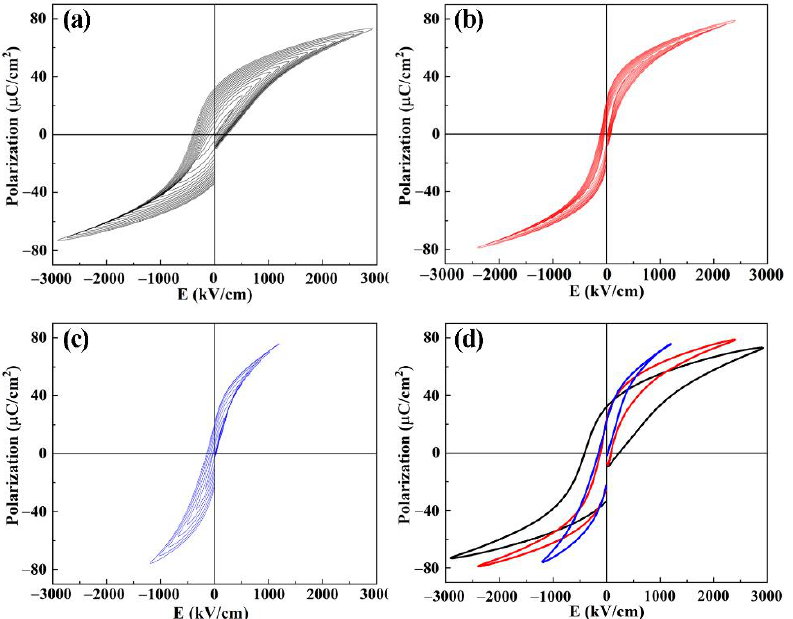
Figure 5. P – E hysteresis loops of PMN-PT-2Fe thin films annealed at various temperatures ( a ) 600 °C, ( b ) 650 °C, ( c ) 700 °C, ( d ) P – E hysteresis loops at breakdown strength.